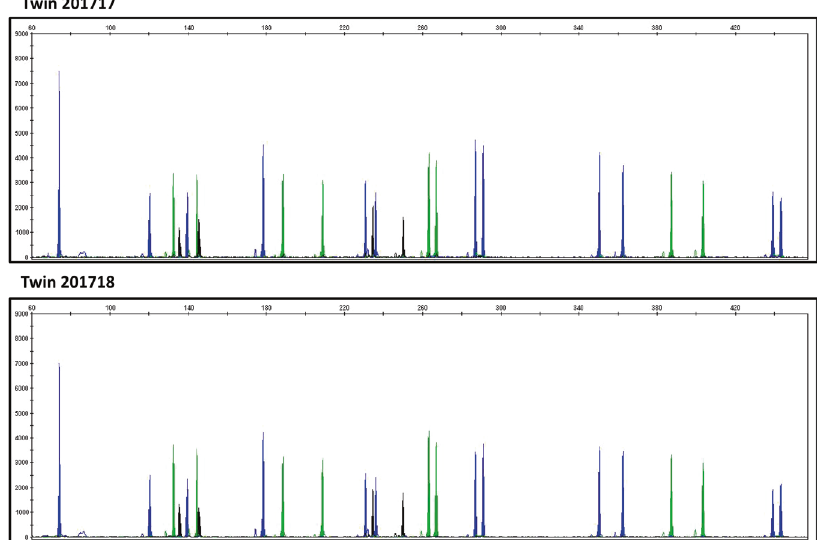
Fig. 1 Monozigosity analysis in the discovery cohort. Two representative examples of the determination of monozygosity using microsatellite